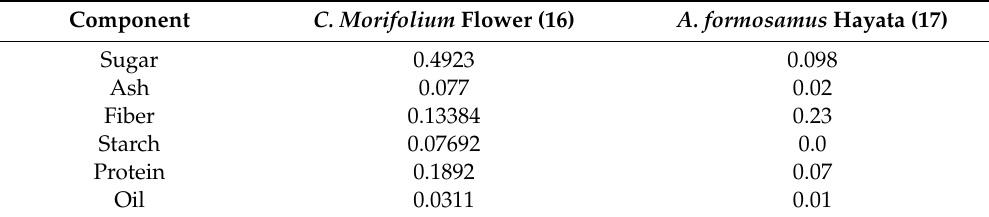
Table 5. Chemical composition of C. morifolium flower and A. formosamus Hayata.